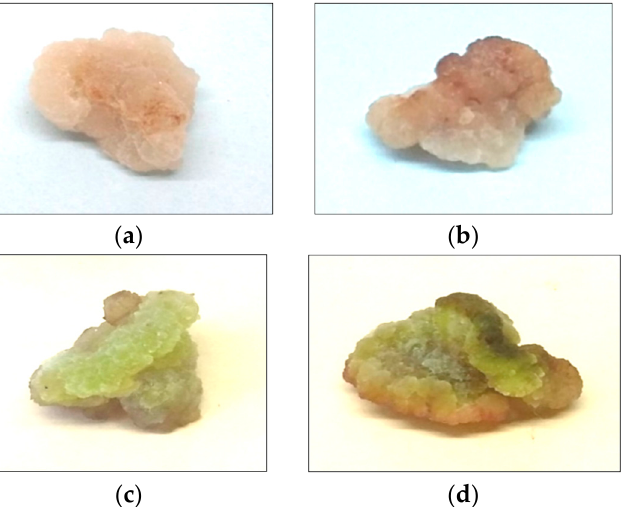
Figure 1. Established callus cultures initiated from stem explants of tea ( Camellia sinensis L.)